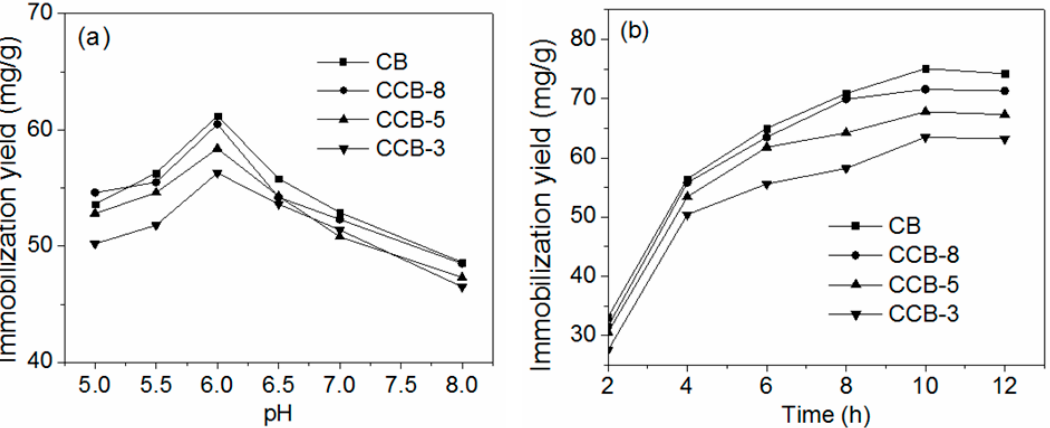
Figure 3. Immobilization yield of lipase on chitosan bead and clay/chitosan composite beads vs. pH ( a ) and contact time ( b ). Initial enzyme concentration: 10 mg/mL, agitation speed: 180 rpm, temperature: 25 °C.